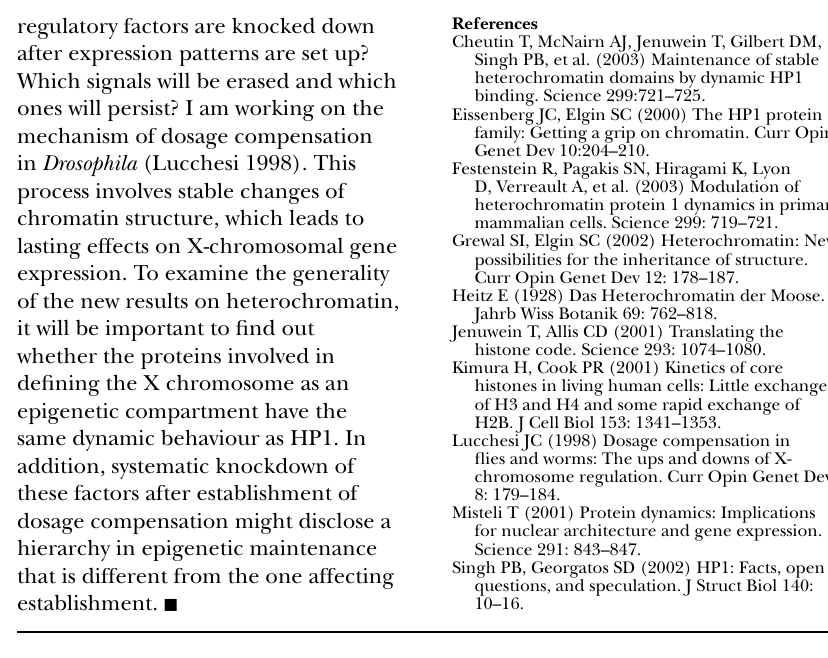
Figure 1. FRAP of HP1–GFP Reveals a Dynamic Association with Heterochromatin A fraction of a heterochromatic cluster (arrowhead) was bleached by a laser pulse, and recovery of fluorescence was monitored by time- lapse imaging. Images were kindly provided by Thierry Cheutin and Tom